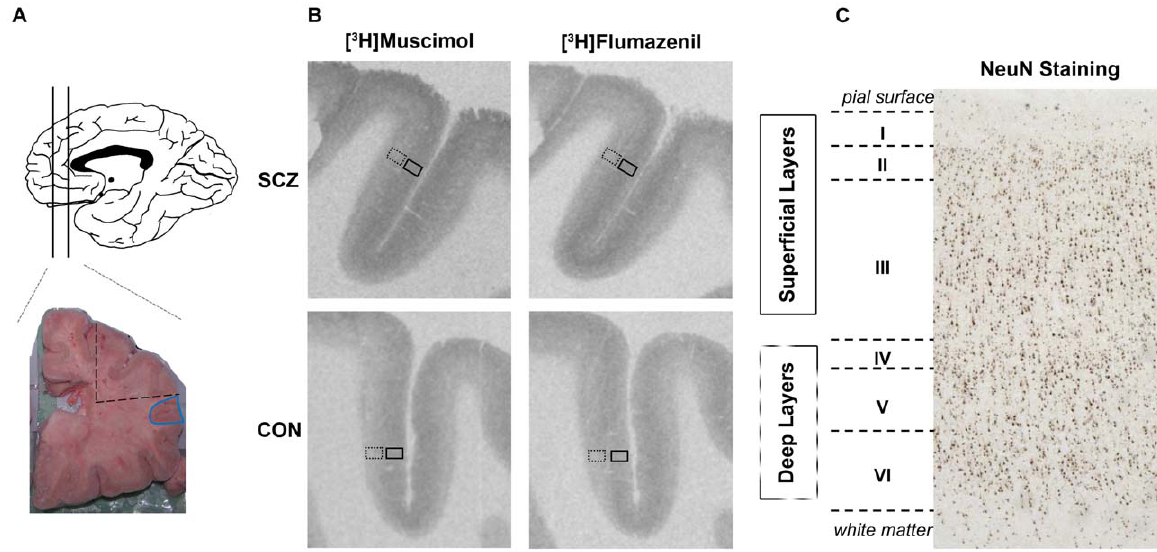
Figure 1. An overview of the experimental procedures used in the autoradiography experiments. A Sagittal view of brain with lines indicating area of coronal section with the blue outlined area is where homogenate tissue was isolated with the dashed lines indicating the bounds of tissue slices used for autoradiography (A). Typical autoradiographs (B) obtained with [ 3 H]Muscimol (GABA orthosteric binding site agonist) and [ 3 H]Flumazenil (benzodiazepine allosteric binding site antagonist) in the DLPFC of control (CON) and schizophrenia (SCZ) cases. NeuN staining (C) that allowed identification of the cortical layers in the DLPFC is presented on the right side of the figure, along with the drawing methodology used to quantify binding in the ‘‘superficial’’ (layers I, II, and III) and ‘‘deep’’ layers (layers IV, V and VI) of the DLPFC. The superficial layers quantification ‘‘box’’ is indicated in solid line, while the deep layers quantification ‘‘box’’ is indicated in dotted line.